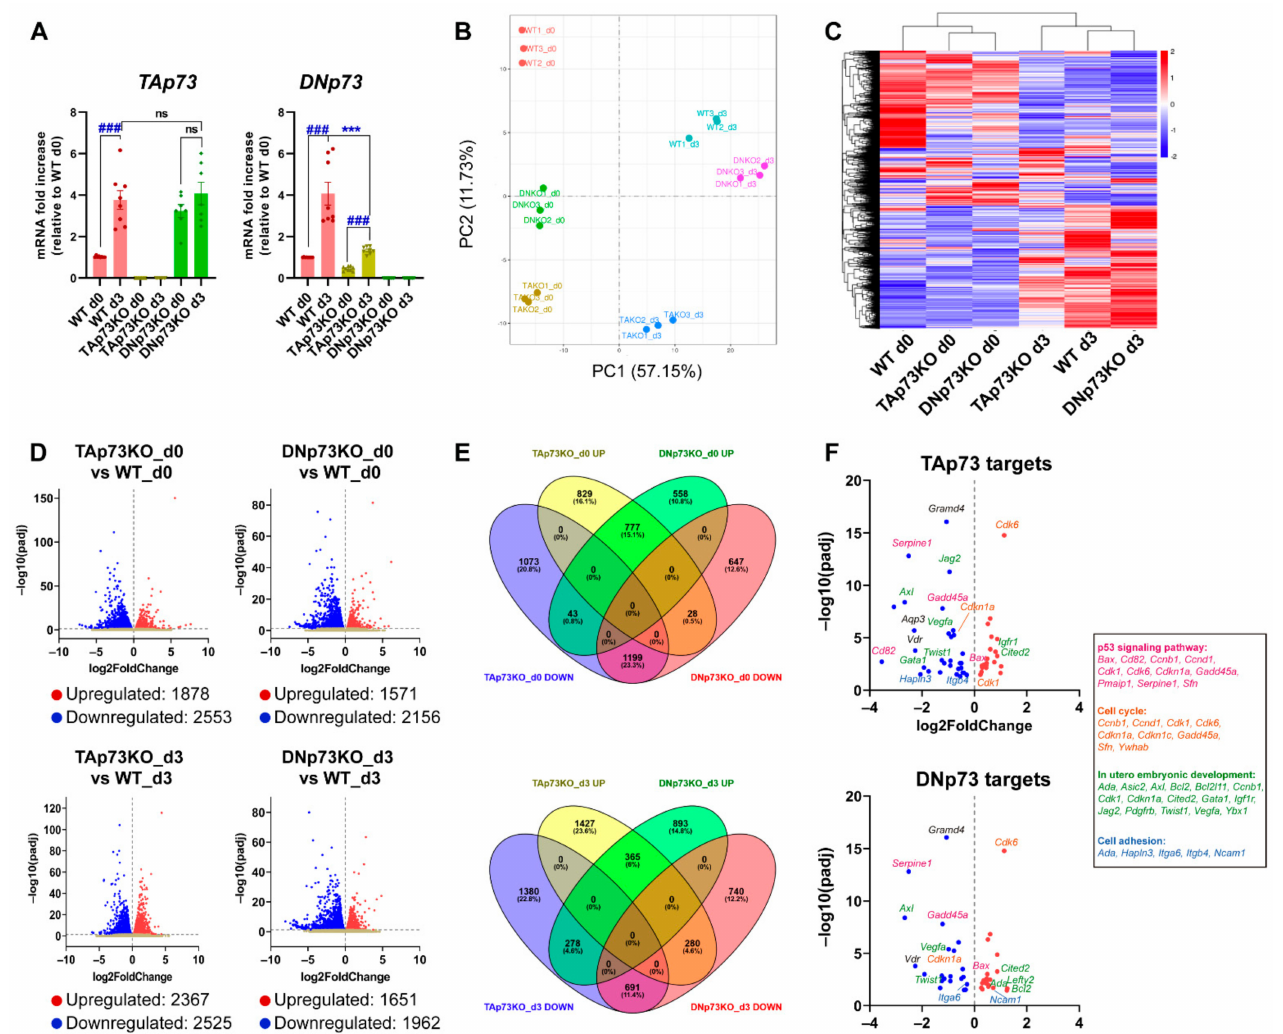
Figure 3. Elimination of the TA- or DN-p73 isoforms results in alteration of mESC transcriptional profiles with some genes showing isoform-specific deregulation, while others are affected by either isoform knockout. ( A ) Expression of p73-isoforms, analyzed by qRT-PCR, under differentiation-permissive conditions (after three days of EBs culture, d3) compared to stemness basal conditions (d0, S/L). At least, three independent experiments were performed. ***, ### p -value < 0.001. ( B ) Two-dimensional principal component analysis (2D PCA) score plot showed that samples clearly segregate from each other, demonstrating clear transcriptional differences among groups. ( C ) Hierarchical clustering analysis of expressed transcripts in the different cell lines under either stemness (d0) or differentiation-permissive conditions (d3). ( D ) Volcano plots of differentially expressed genes between E14-TAp73KO and E14-DNp73KO samples vs. E14-WT controls at the differ- ent time points analyzed. The estimated log2 Fold Change is plotted against log10 adjusted p -value (p-adj). Upregulated and downregulated genes are highlighted as red and blue dots, respectively. Genes that are not differentially expressed are represented as gray dots. ( E ) Venn Diagrams illustrating the relationship of up and down-differentially expressed transcripts in E14-TAp73KO and E14-DNp73KO samples compared to E14-WT controls at day 0 and day 3. The percentage of changed transcripts in each group is shown in parentheses. ( F ) Volcano plots showing differentially expressed genes (DEGs) between knockout cells and WT controls (S/L conditions) that were found to be common to a panel of validated p73 targets associated with p73 canonical and noncanonical functions. Genes associated to GO terms “p53 signaling pathway” (pink), “cell cycle” (orange), “in utero embryonic development” (green) and “cell adhesion” (blue) are